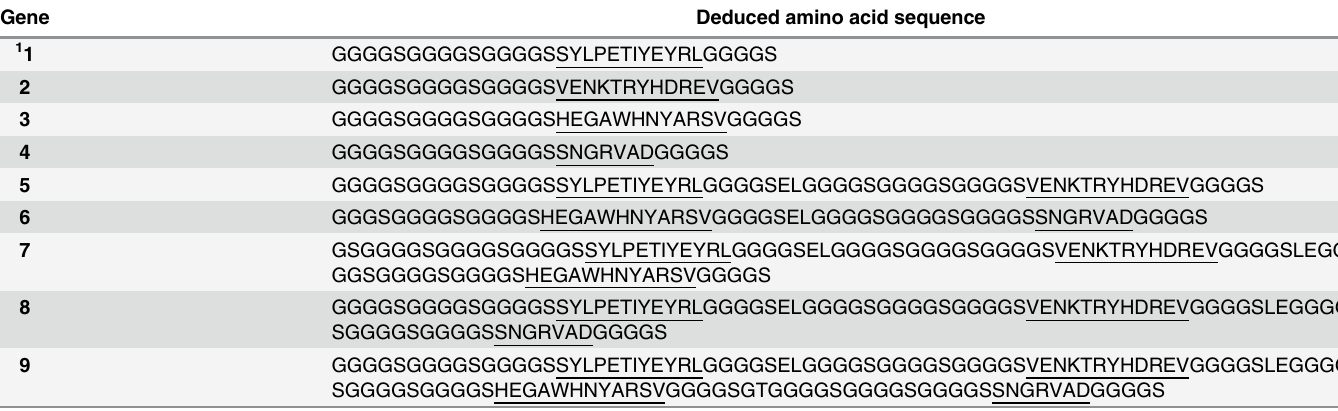
through PEP4; Table 5) were commercially synthesized (NeoBioLab, Woburn, MA). Consider- ing the high cost of synthesizing longer peptides, we restricted our study to the four basic Table 3. Deduced amino acid sequences of nine synthetic peptide genes. Gene Deduced amino acid